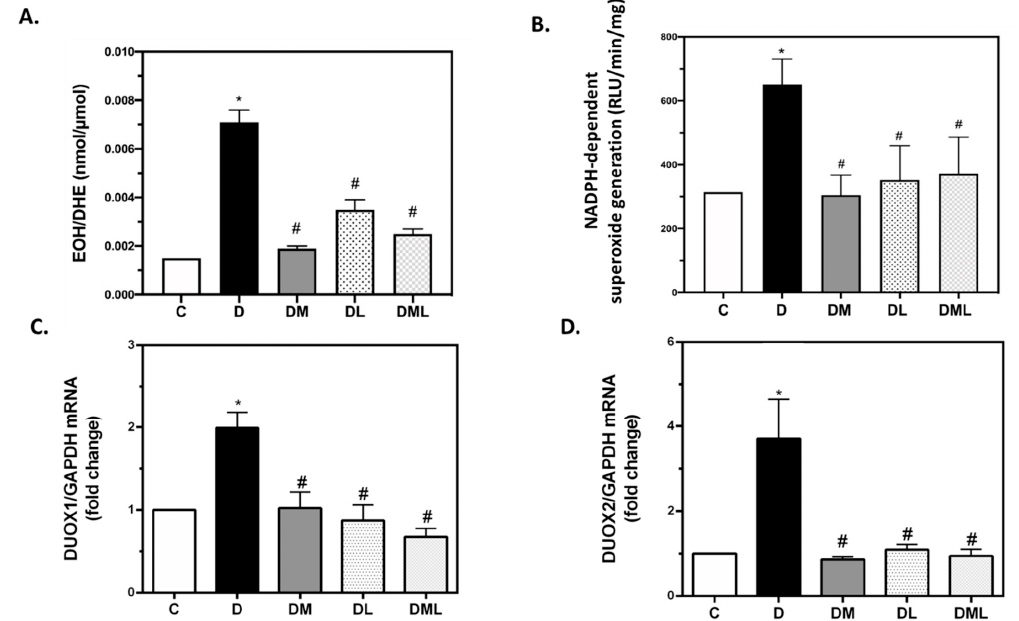
Figure 3. ROS production, NADPH oxidase activity and DUOX1/DUOX2 mRNA expression in the kidneys. ( A ) Bar plot reflecting ROS production through EOH/DHE ratio quantification. ( B ) Bar plot reflecting NADPH oxidase activity. ( C , D ) Bar plots representing the differential expression of DUOX1 and DUOX2 normalized against GAPDH expression respectively. GAPDH: glyceraldehyde 3-phosphate dehydrogenase. All data are expressed as mean ± SEM. * p ≤ 0.05 diabetic vs. control groups. # p ≤ 0.05 treated vs. diabetic